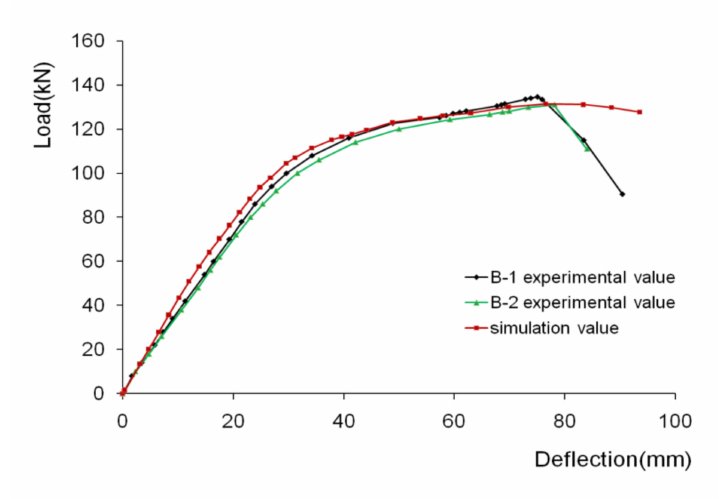
Figure 15. Comparison of experimental and simulated load deflection curves.